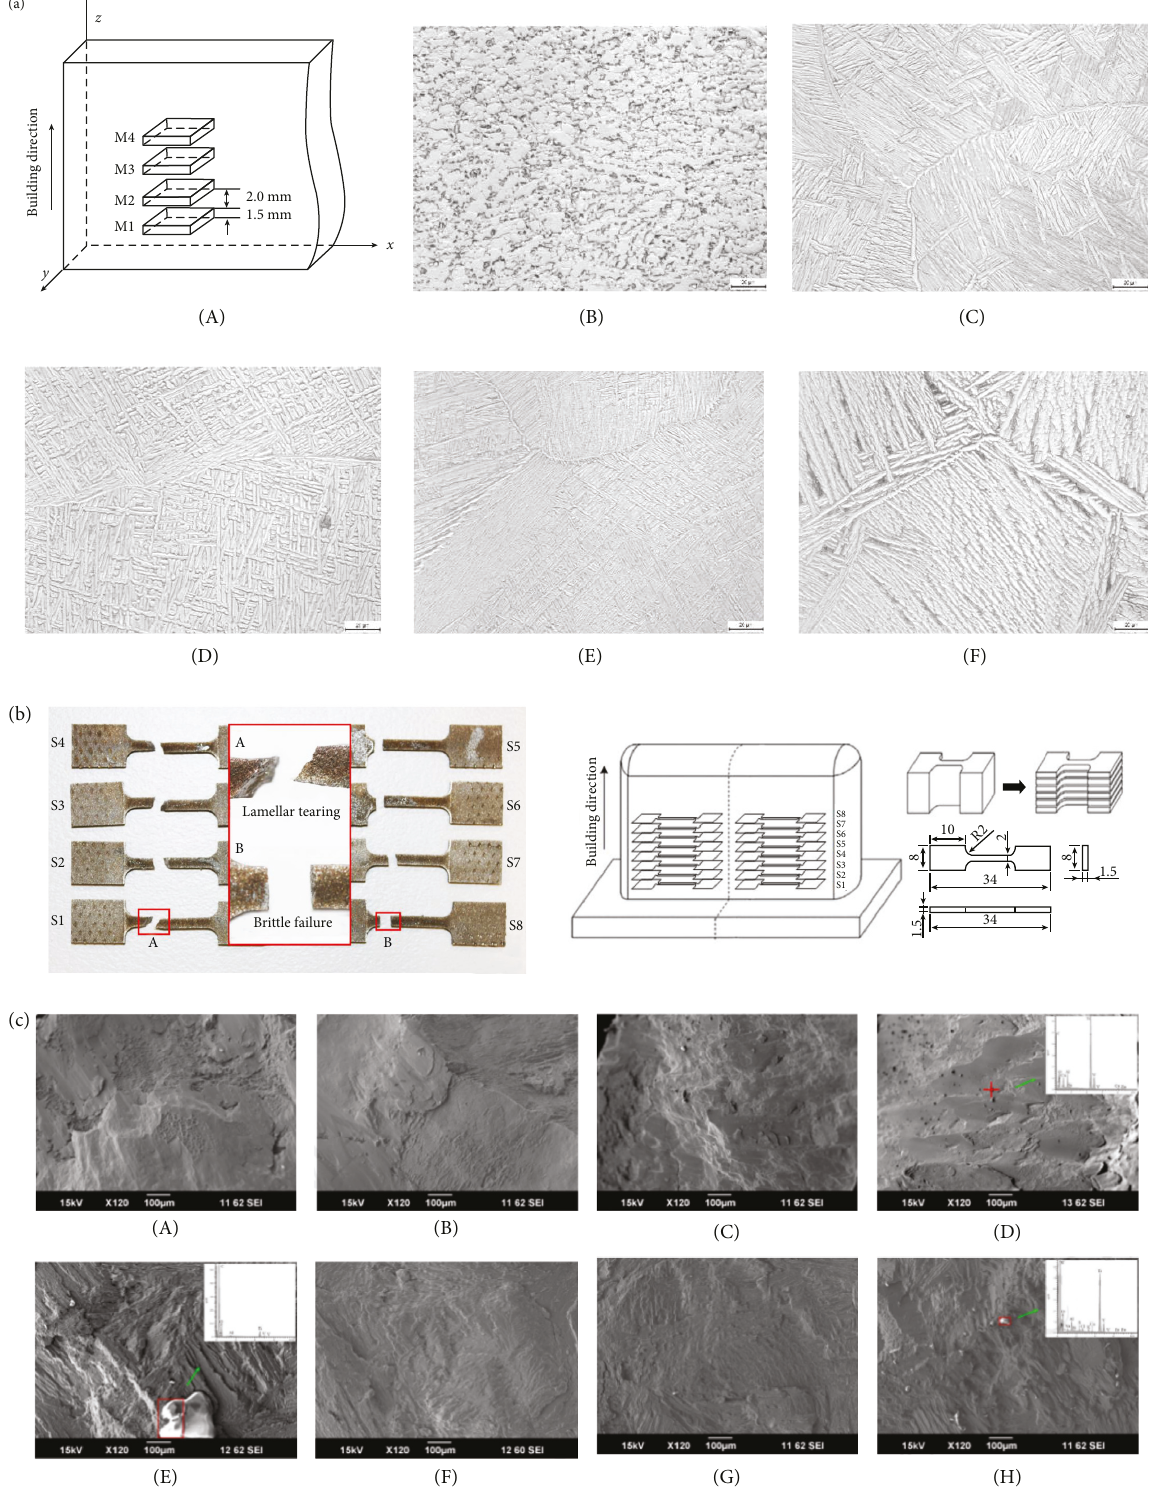
Figure 1: (a) Optical micrographs of selected samples in different horizontal planes: (A) schematic of the sample locations; (B) base metal extracted from a region outside of the heat affect zone; (C) M1; (D) M2; (E) M3; (F) M4. (b) The fracture appearance of the tensile specimens. (c) High-magnification fractographs of corresponding tensile samples: (A) S1; (B) S2; (C) S3; (D) S4; (E) S5; (F) S6; (G) S7; (H)